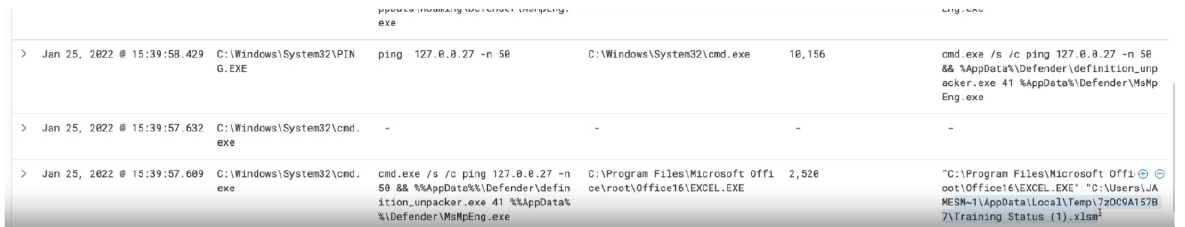
Figure 15. Process ID filtering results (logs).